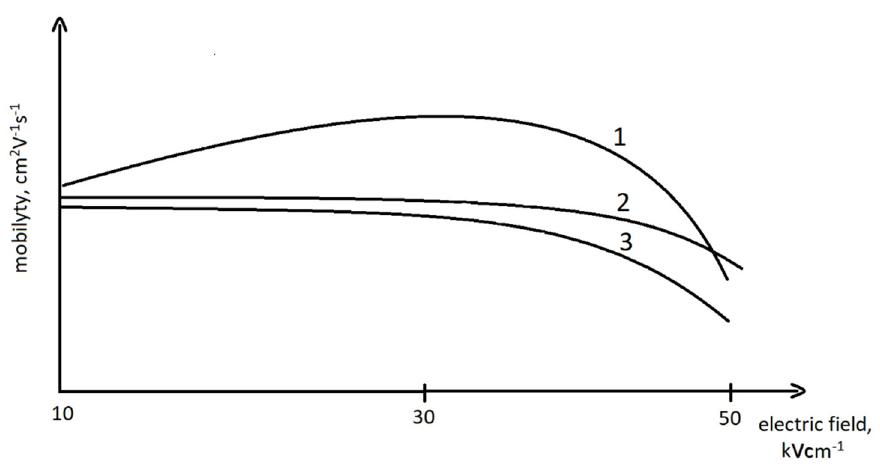
Figure 2. Dependence of ions’ mobility on electric field tension within the DMS detector. 1: common behavior of ions; 2 and 3: behavior of heavy ions and dimers, respectively.